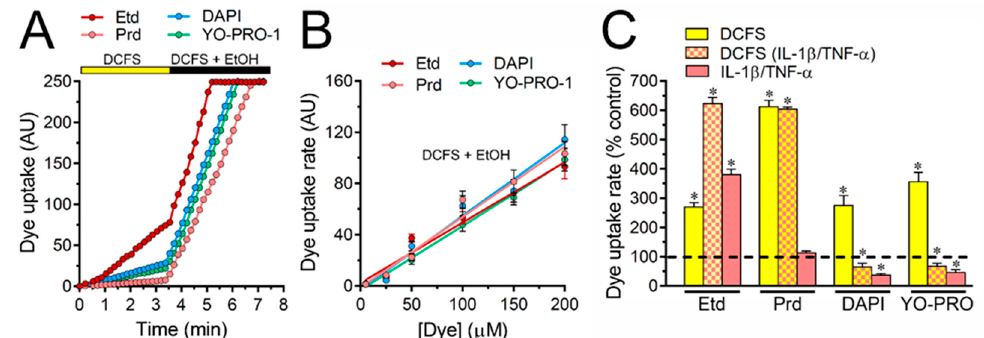
Figure 4. Maximum rate of dye uptake through astroglial Cx43 hemichannels is not due to saturation of intracellular binding sites. ( A ) Time-lapse measurements of Etd (dark red), Prd (light red), DAPI (blue) or YO-PRO-1 (green) uptake by astrocytes bathed in DCFS and then exposed to DCFS plus 70% v/v ethanol. Each value expresses the average of the fluorescence intensity in 20 cells; ( B ) Regression analysis showing the relationship between dye uptake rate and increasing concentrations of Etd (dark red), Prd (light red), DAPI (blue) or YO-PRO-1 (green) by astrocytes bathed with DCFS and permeabilized with 70% v / v ethanol. The fluorescence intensity was evaluated during initial velocity in three time periods separated by 15 s; ( C ) Dye uptake rate normalized to the amount of Cx43 reactivity found in the cell contour in control (yellow bars) or IL-1 β /TNF- α -treated (red-yellow dashed bars) astrocytes bathed with DCFS. It is also shown the dye uptake by IL-1 β /TNF- α -treated astrocytes bathed in normal saline (red bars). Cells were exposed for 5 min to 5 µM of each dye. * p < 0.05, respective control (dashed line) vs. treatments (two-way ANOVA followed by Tukey’s post hoc test). Data were obtained from at least three independent experiments with four repeats for each one ( ≥ 25 cells analyzed for each repeat).